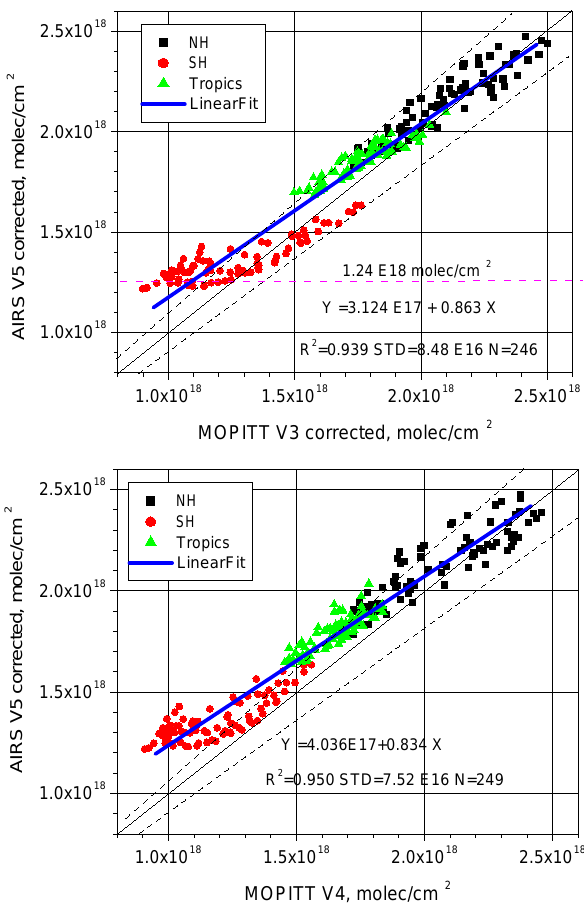
Fig. 9. Comparison of monthly mean CO TC measured by AIRS (V5 corrected) and by MOPITT (V3 corrected and V4) and aver- aged over mid-latitudes of both hemispheres and over